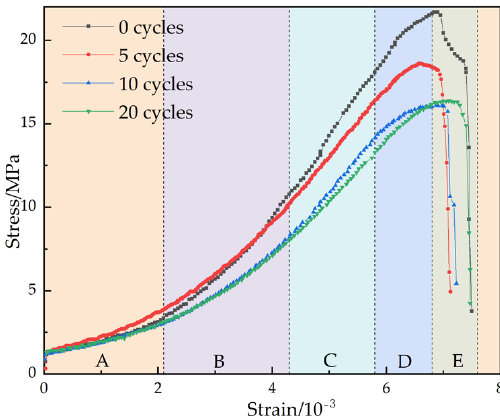
Figure 5. Stress–strain curves of typical fracture–grouted rock specimens under different numbers of wetting–drying cycles.